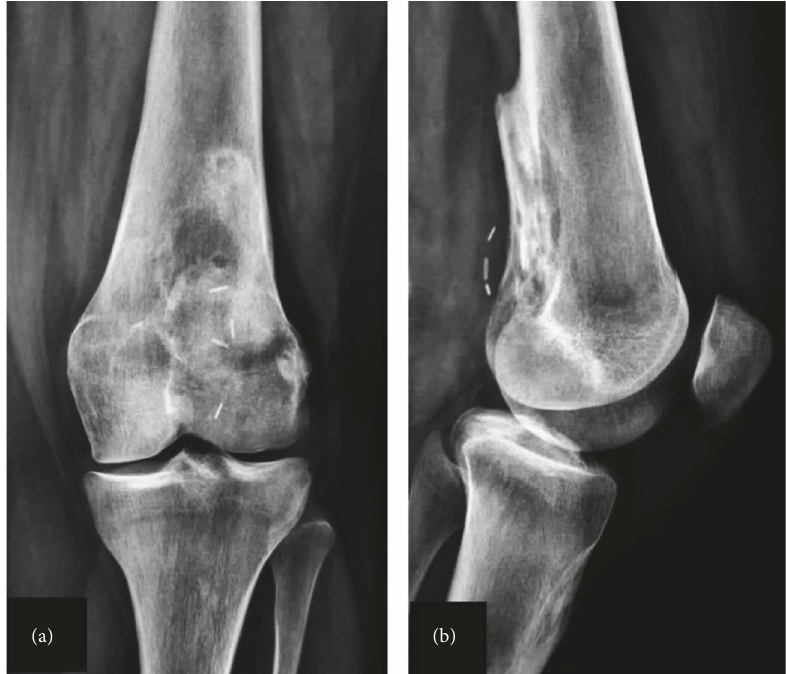
Figure 8: Parosteal osteosarcoma (PAO) in a 16-year-old female (no. 6). Anteroposterior (a) and lateral (b) radiographs four years after operation showing recurrence of